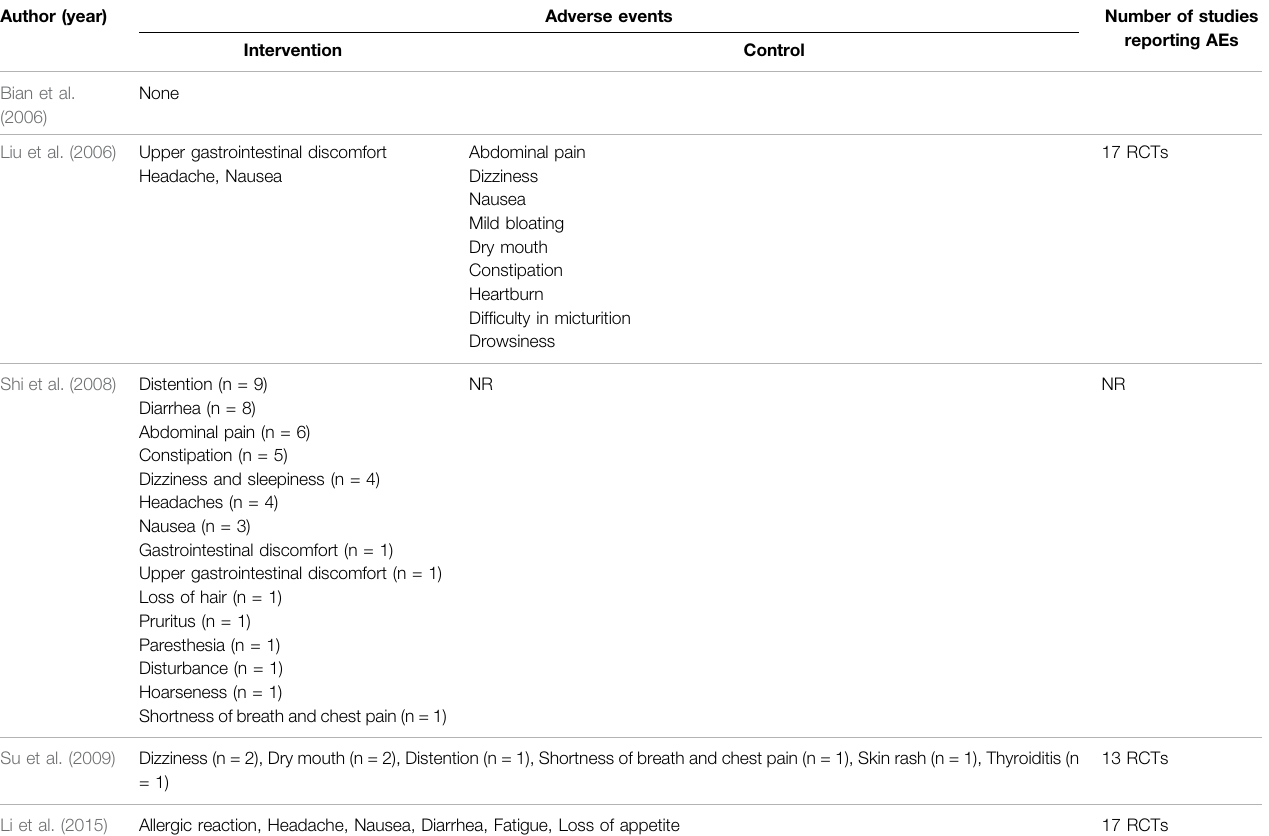
TABLE 4 | Details of adverse events among included systematic